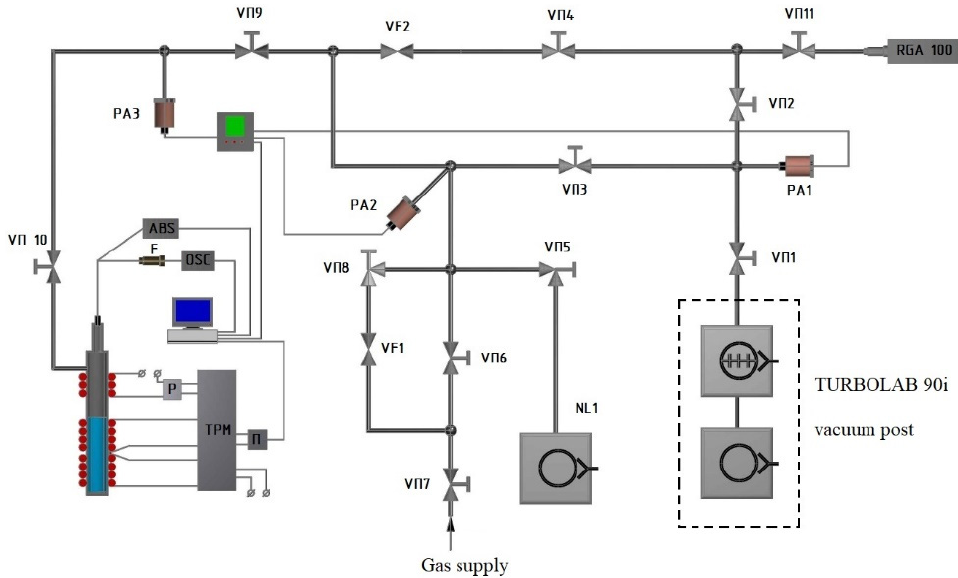
Figure 2. Scheme of experimental facility: NL 1—spiral pump; VP1 . . . VP10—vacuum valves; PA1 . . . PA3—pressure sensors; VF1, VF2—leakage valve; RGA 100—quadrupole probe/sensor (mass-spectrometer RGA-100); ABS—optical spectrometer; F—photo detector; OSC—oscilloscope; C—controller for pressure sensor; R—solid state relay for voltage regulation; P—converter of inter-faces RS-485 <-> USB with galvanized isolation; ТРМ— two-channel regulator with universal input and RS.